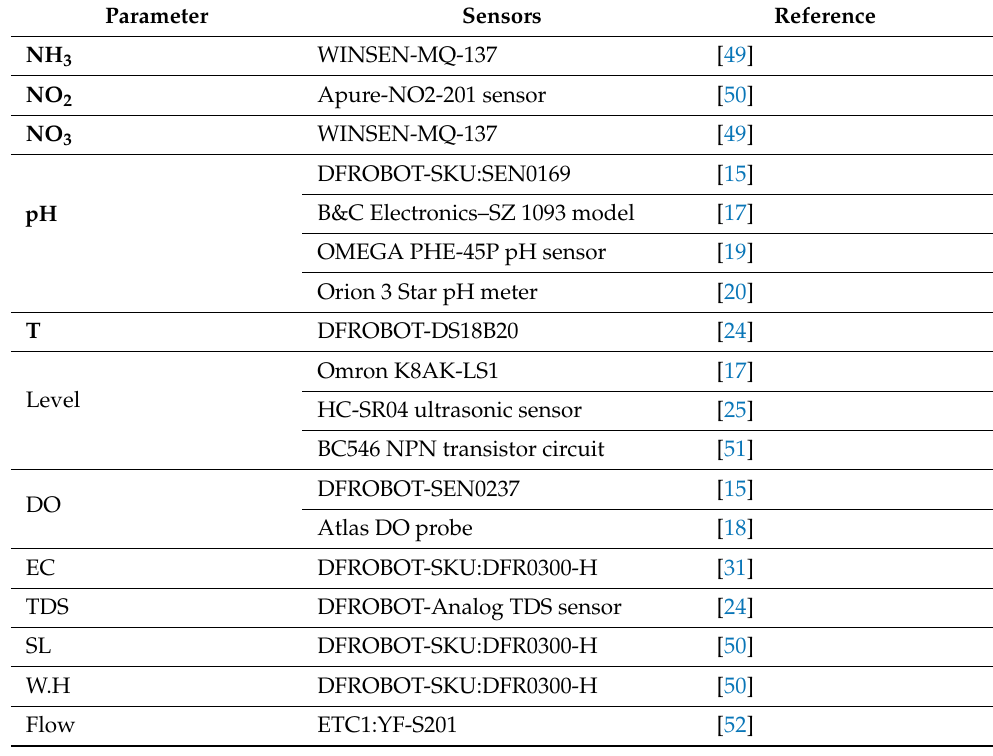
Table 3. Sensors used to monitor different water quality